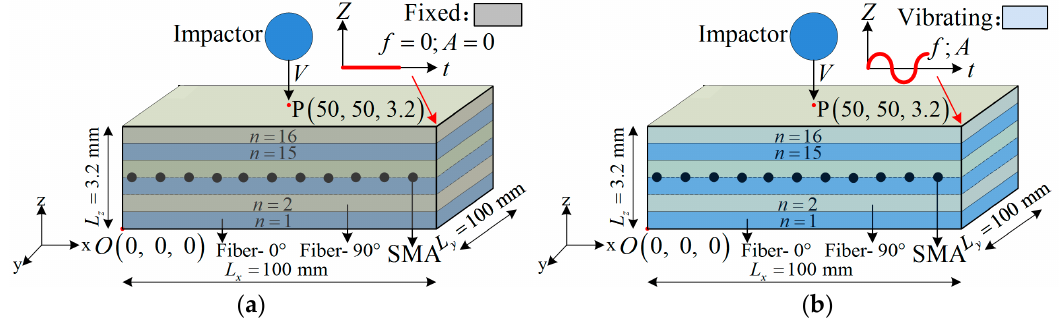
Figure 1. A schematic of the shape memory alloy (SMA)-reinforced composite samples: ( a ) Fixed boundary; ( b ) Vibrating boundary.